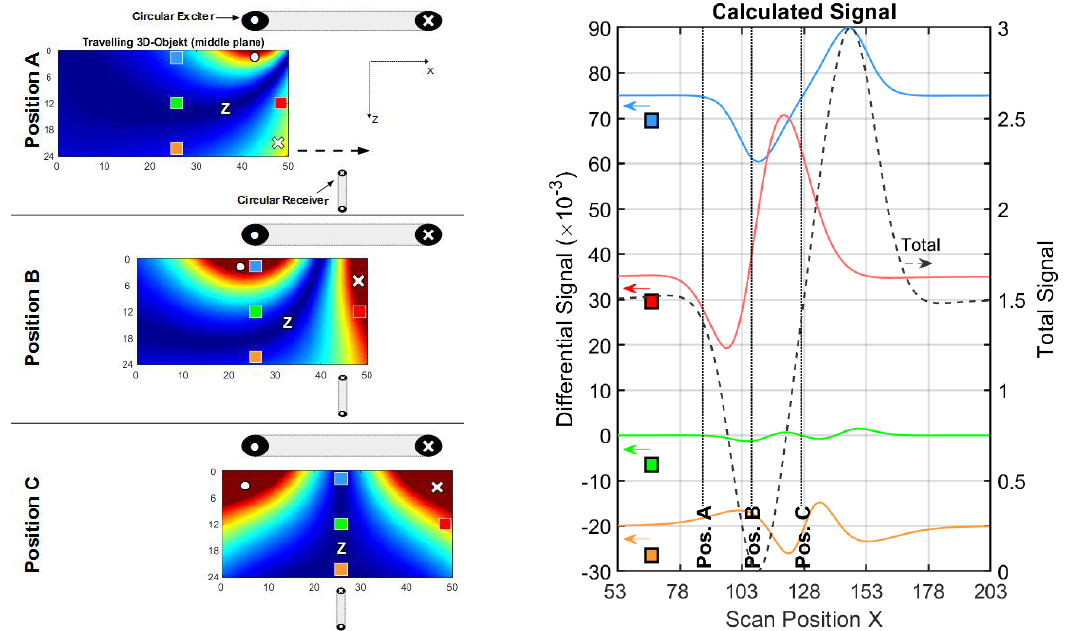
Figure 9. Current and signal calculations with a circular setup (cf. Figures 2 and 3a); (left) Eddy current density distribution in the horizontal middle plane of a conducting volume. Three positions (A, B and C) of the travelling cuboid are shown. Local voids at four characteristic positions inside the travelling cuboid (blue, green, orange and red squares) are analyzed; (right) Total signal (dotted black) and differential signals (blue, green, orange and red lines) for the four voids. T able 4. Main results from the calculated signals, shown in Figure 9. Total Signal Edge Diff. Signal Center Diff. Signal Edge (max. amplitude) (max. amplitude) (max. amplitude) Sensitivity 1 1 Ratio between the differential signal and the total signal.